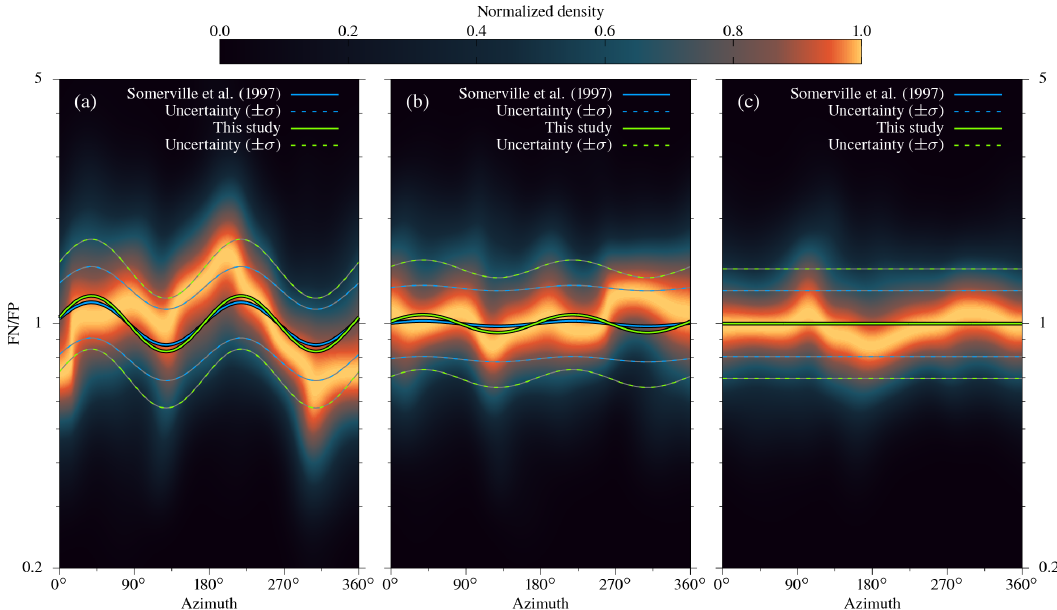
Figure 11. Kernel density estimate of FN / FP with azimuth obtained from response spectra for three different oscillatory frequency ranges: